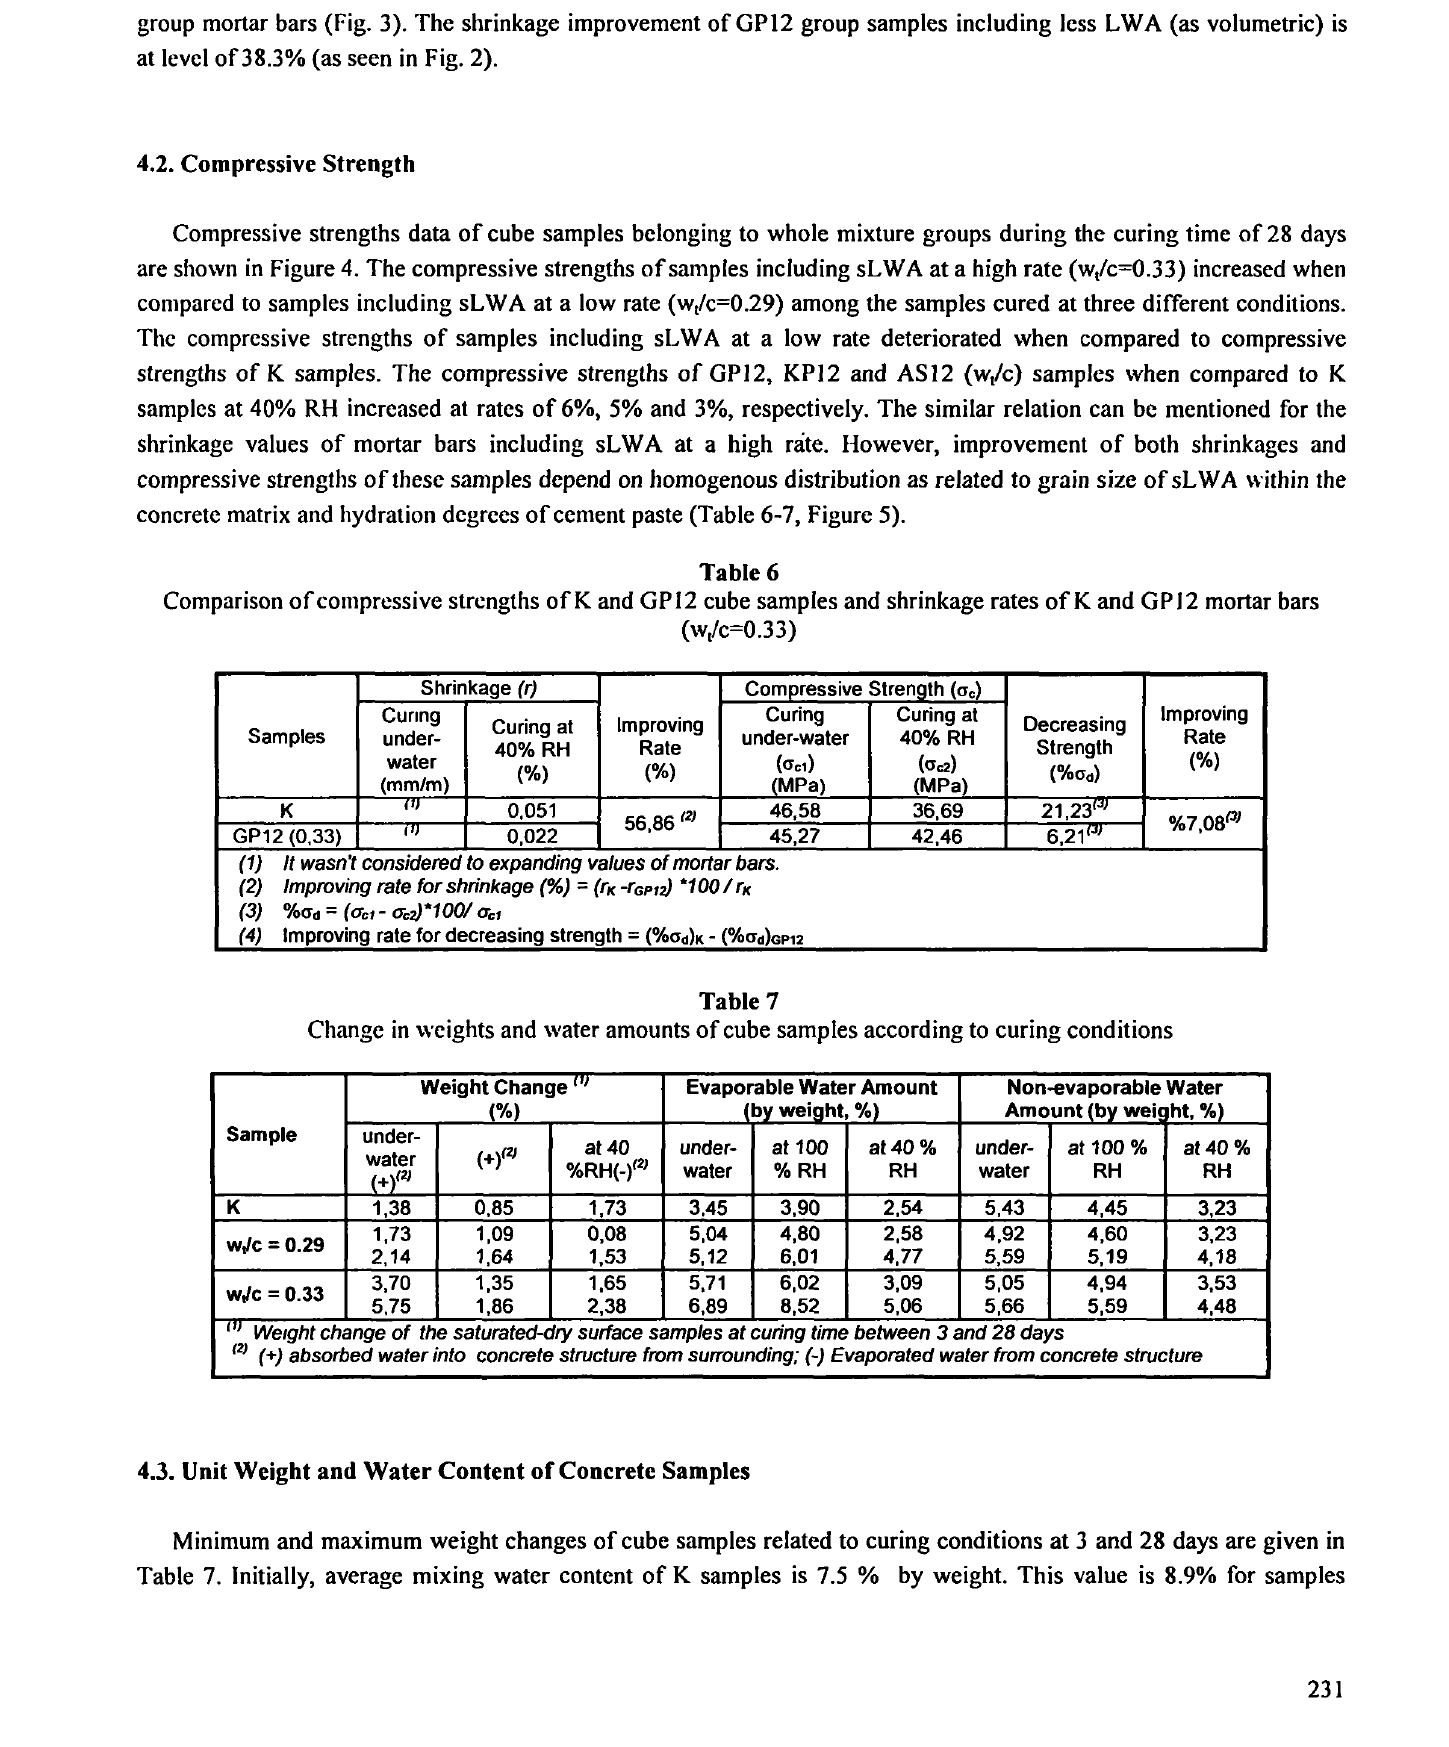
Comparison of compressive strengths of K and GPI2 cube samples and shrinkage rates of K and GPI2 mortar bars